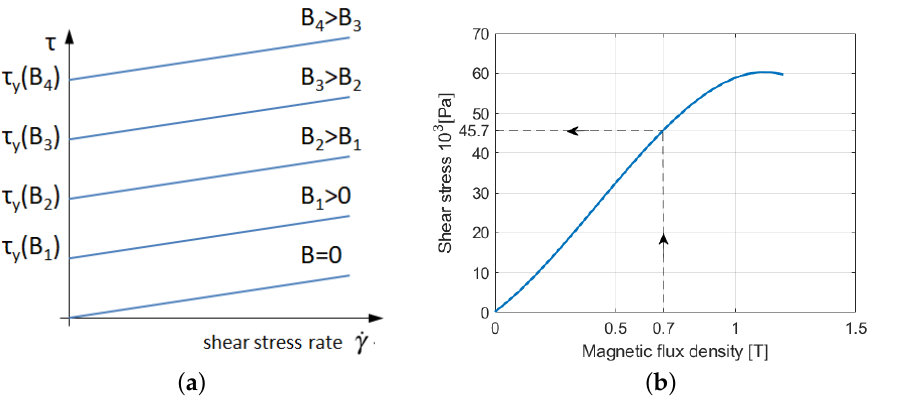
Figure 5. Graphical representation of Bingham model ( a ). Yield stress characteristics τ ( B ) for MRF-140CG [16] ( b